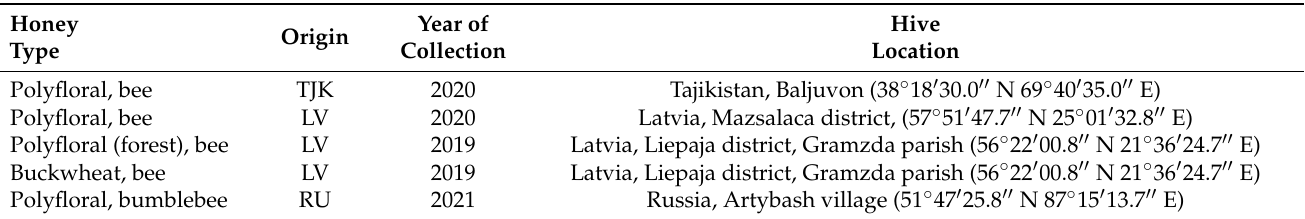
Table 1. Detailed characteristics of honey samples subjected to